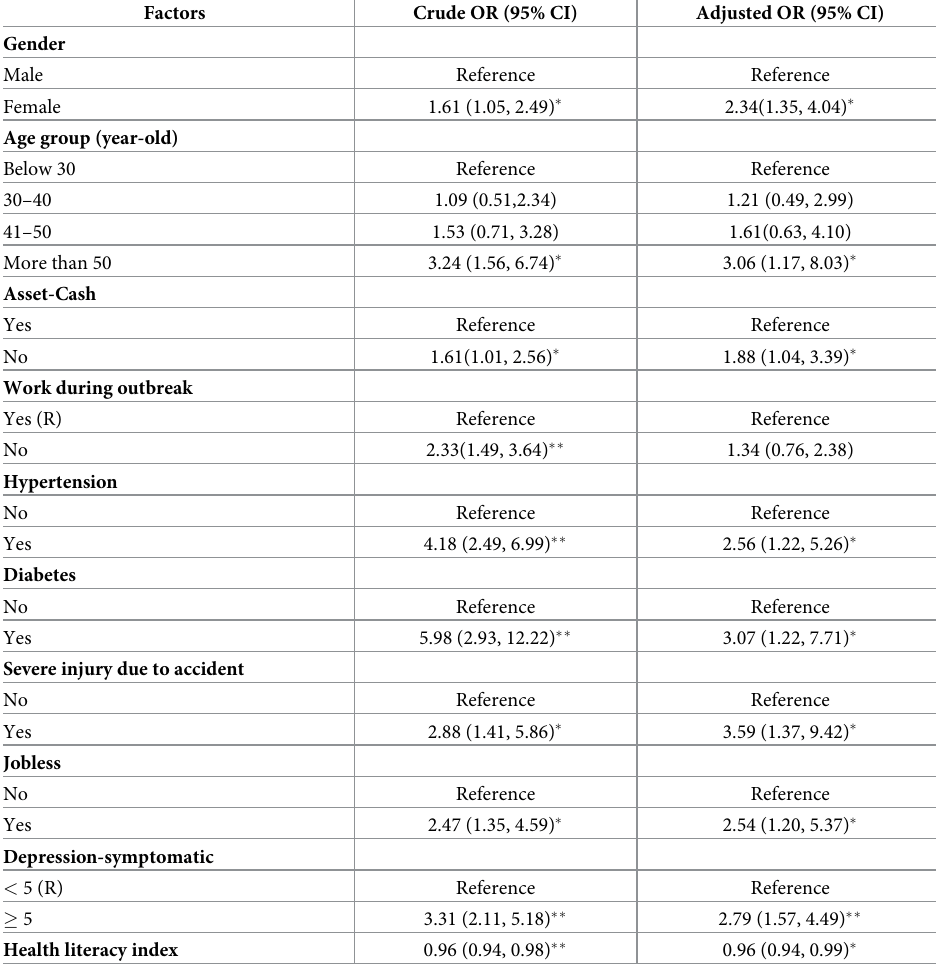
Table 3. Simple and multivariable logistic regression on factors associated with EQ-5D (n =